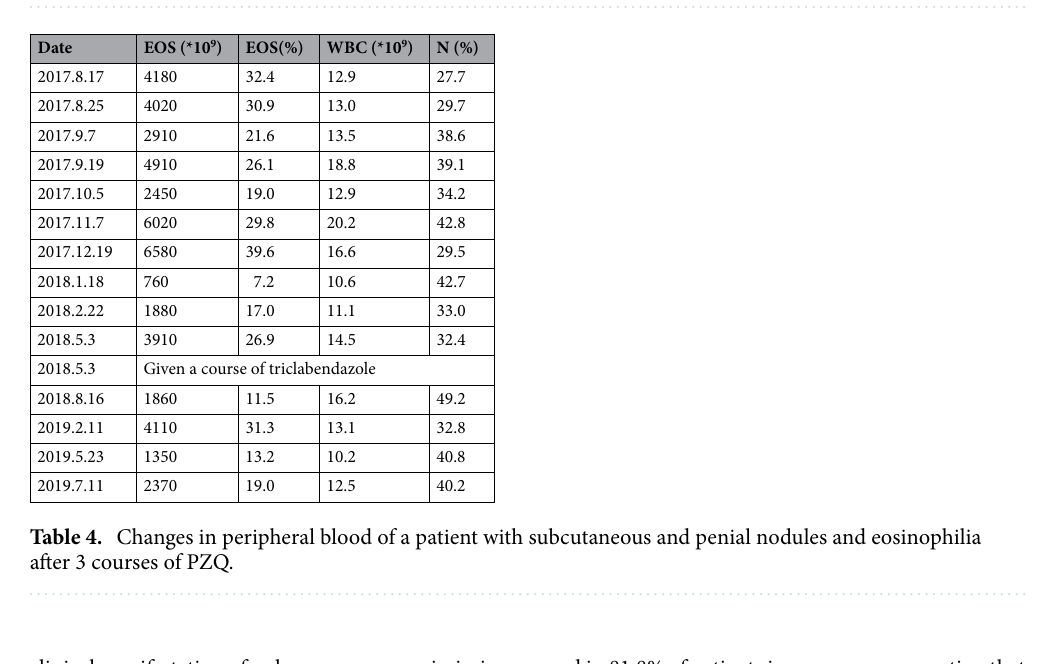
Figure 2. A 4-year-old boy presented with paroxysmal headache and vomiting. ( A – D ) Characteristic ring- like lesions with surrounding edema (white arrowhead) and calcifications (black arrowhead) located in the left frontoparietal lobe showed by cranial CT ( A ), T1WI ( B ), T2WI ( C ) and enhanced MRI ( D ); ( E – F ) Chest MRI indicated the nodules in the lower lobe of the right lung.